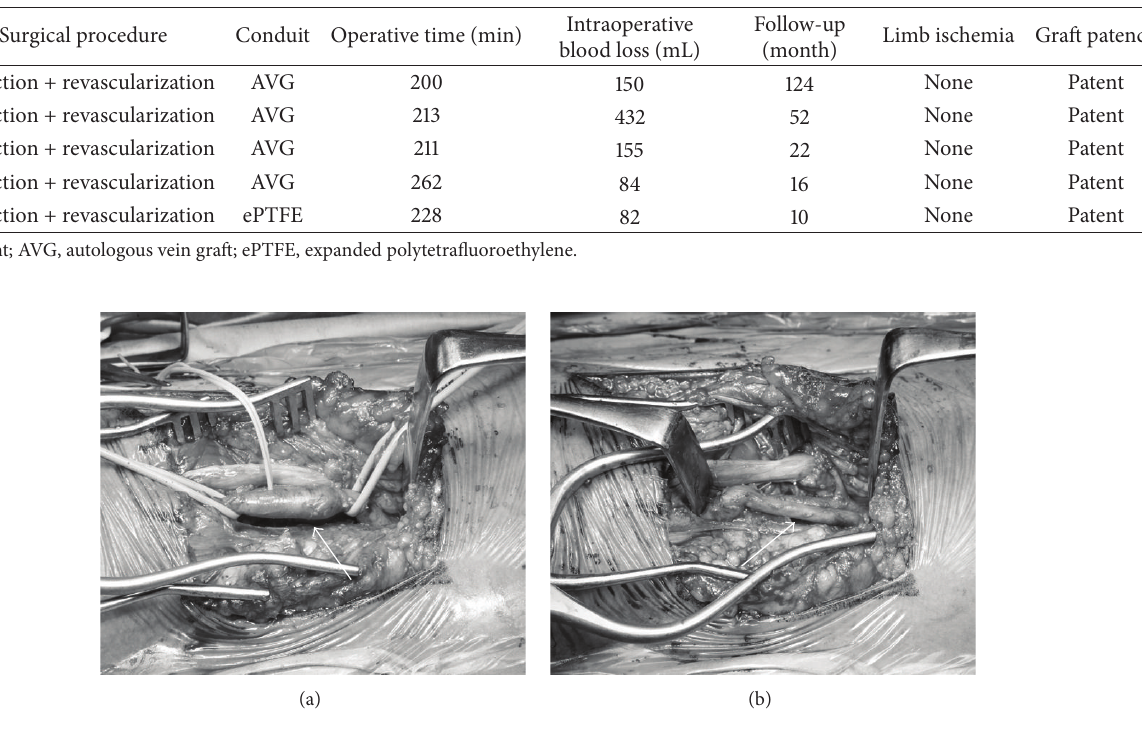
Figure 4: Intraoperative findings showing (a) the controlled left popliteal artery (white arrow) and (b) the performance of resection with graft interposition (white arrow). The patient’s head was to the right.